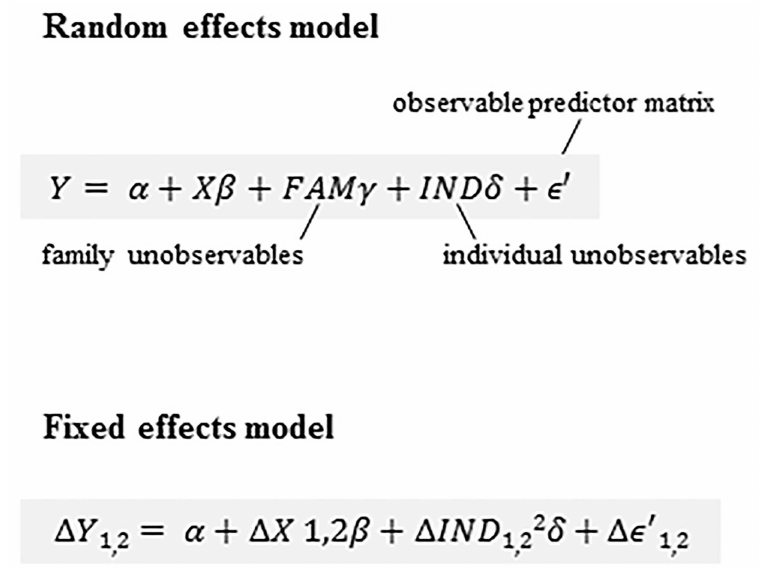
Fig 2. The fixed effects model. The β coefficient gives an estimate of the difference betweenexposedand non-exposed siblingclusters.